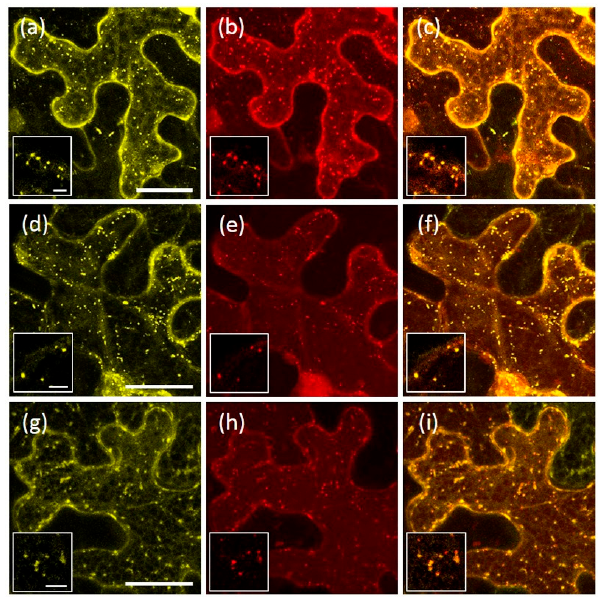
Figure 7. Co-expression of AtRMR2-RFP with either AtRMR1-YFP or its deletion mutants. Stacked confocal images, excepted inserts ( a – i ; single images), of epidermal cells expressing the following combinations: ( a – c ) AtRMR1-YFP and AtRMR2-RFP; ( d – f ) AtRMR1 Δ Ring-YFP and AtRMR2-RFP; and ( g – i ) YFP-AtRMR1 Δ PA and AtRMR2-RFP. YFP signal ( a , d , g ); RFP signal ( b , e , h ); and